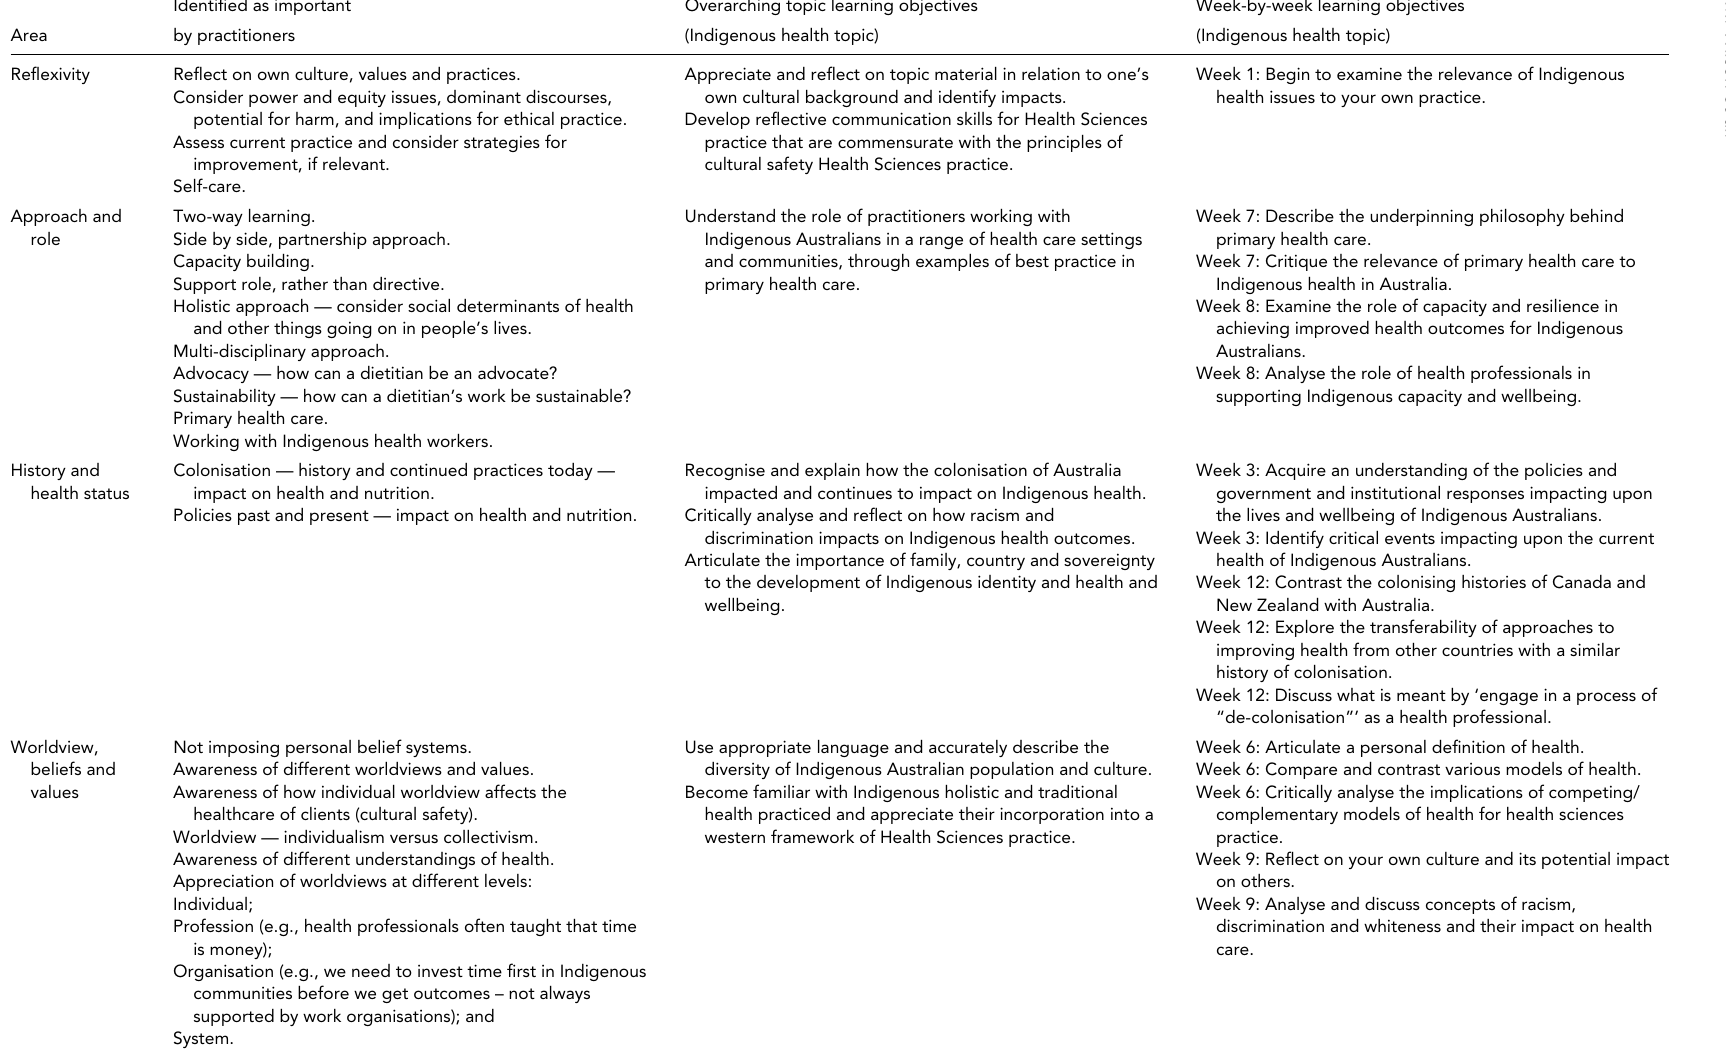
Nine Areas Identified by Dietitians and Nutritionists to be Important When Teaching Indigenous Health to Nutrition and Dietetic Students (the Dietitian Curriculum), Mapped Against Example Learning Objectives from the Poche Centre for Indigenous Health and Well-Being’s Topic, ‘Indigenous Health for Health Sciences’ Identified as